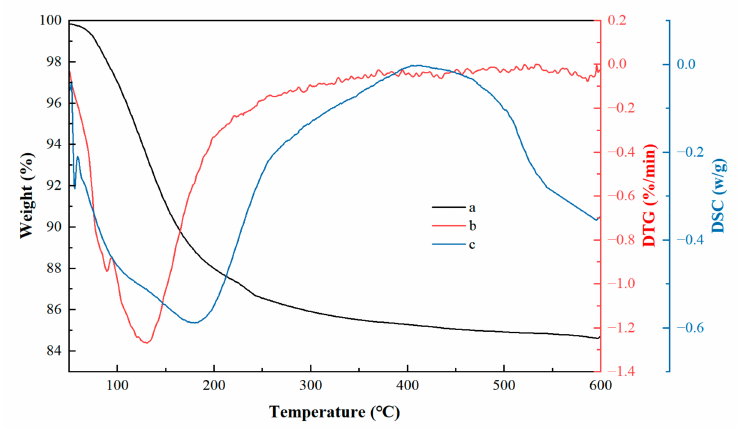
Figure 8. TG-DSC curve of Zn(NO 3 ) 2 -13X: (a) TG curve, (b) DTG curve and (c) DSC curve.